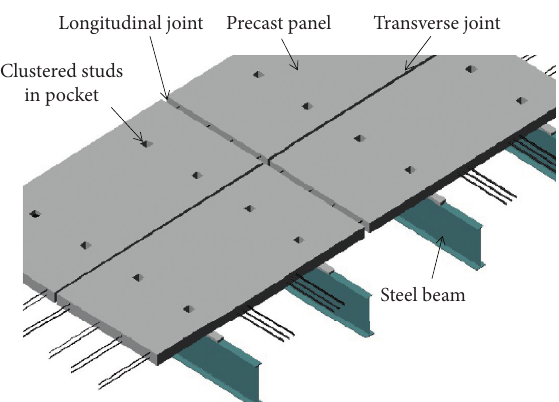
Figure 1: Full-depth precast deck system with stud clusters as the shear connection.